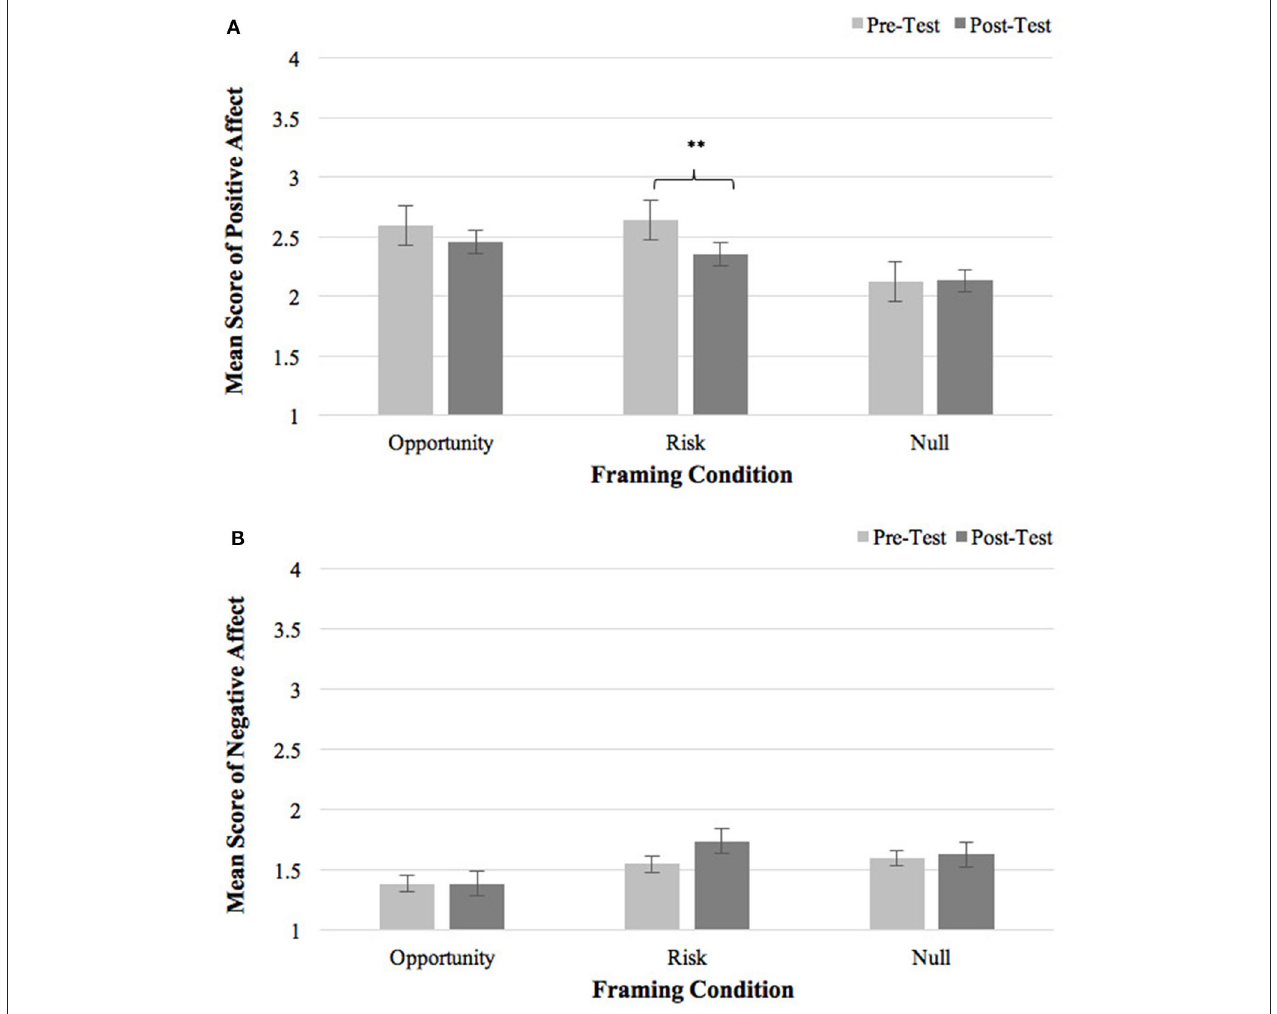
FIGURE 4 | (A) Pre- and post-framing positive affect in three framing conditions. (B) Pre- and post-framing negative affect in three framing conditions. Error bars represent standard errors. ** p < 0.01.